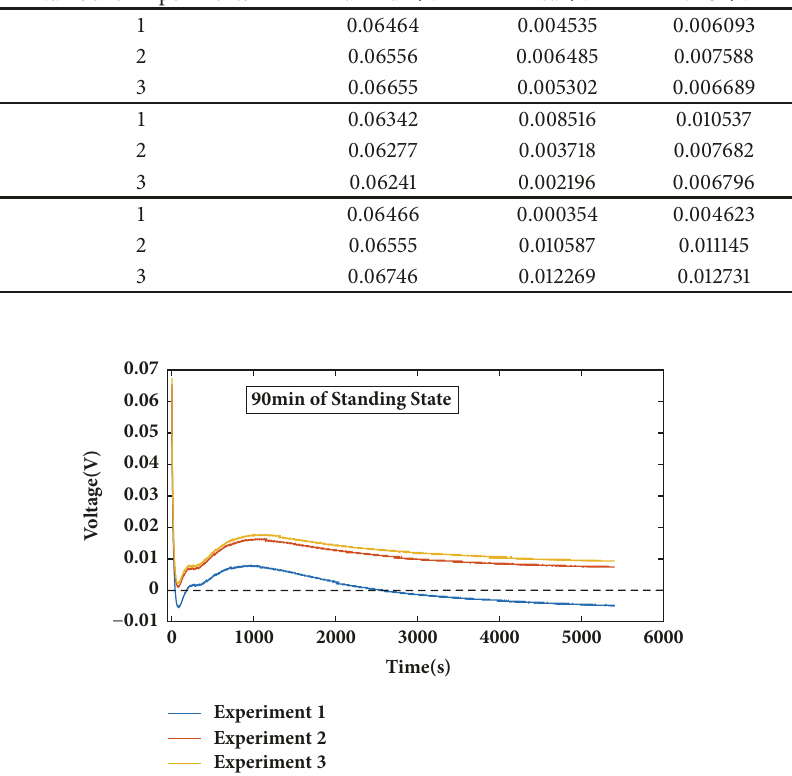
Figure 13: Comparison of the error between the model simulations and experiments measurements at self-healing time of 90